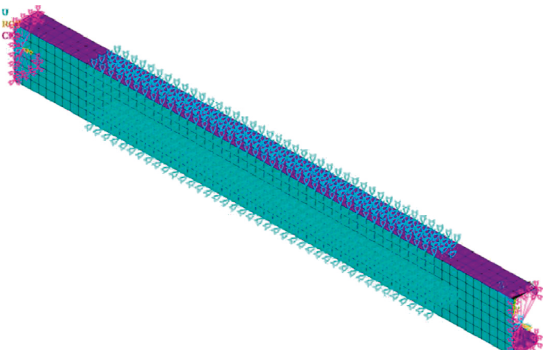
Figure 18: Boundary conditions of braced